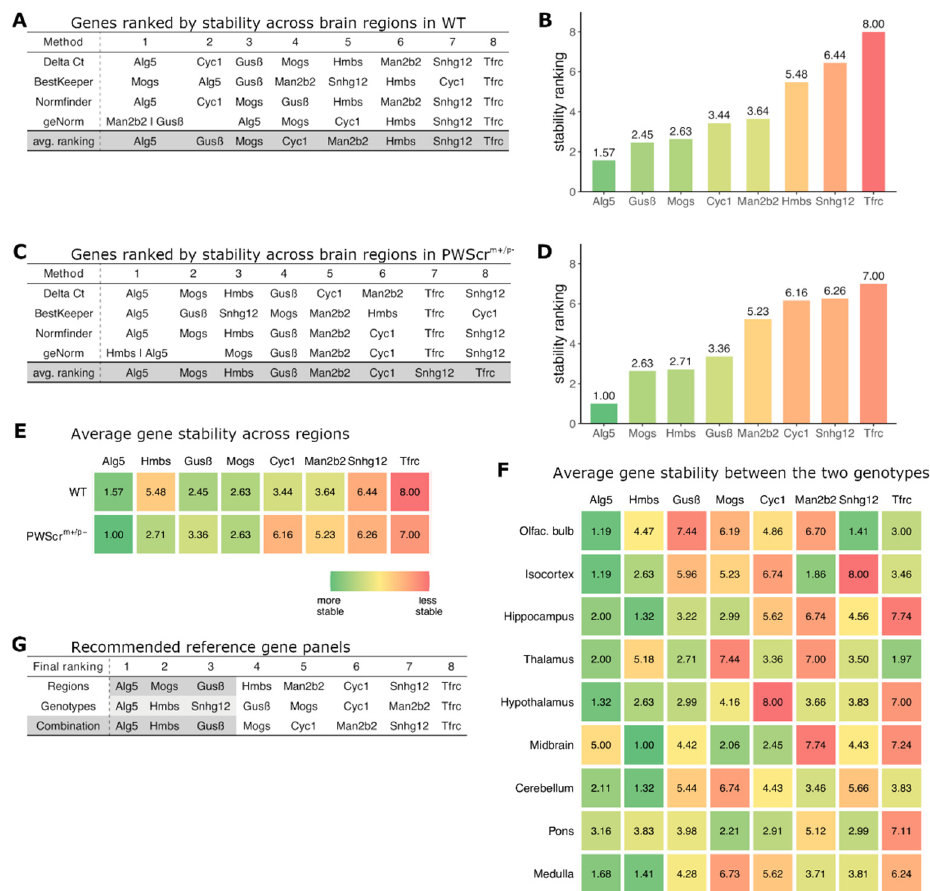
Figure 2. Identification of the reference gene panel. ( A , C ) Expression stability ranking across nine brain regions of reference gene candidates in WT and PWScr m+/p − mice, respectively, determined by four different stability ranking methods. Avg. ranking: shows the calculation of the resulting average ranking of the candidate genes (highlighted in gray; bottom row). ( B , D ) Average ranking position of each of the genes (lower average rank/green is more stable than higher average rank/red) across the nine brain regions of WT ( B ) and PWScr m+/p − ( D ) mice, respectively. ( E ) Average expression stability ranking positions of gene candidates across the nine brain regions in WT (top) and PWScr m+/p − (bottom) mice. ( F ) Average ranking of expression stability between the two genotypes (WT and PWScr m+/p − ) within each of the nine brain regions for the reference gene candidates. ( G ) Compilation of reference gene panel. Regions: average ranking of genes for expression stability within regions of genotypes; genotypes: average ranking of expression stability across investigated genotypes within each brain region; combination: recommended panel of reference genes, i.e., the three highest ranked genes, highlighted in gray.